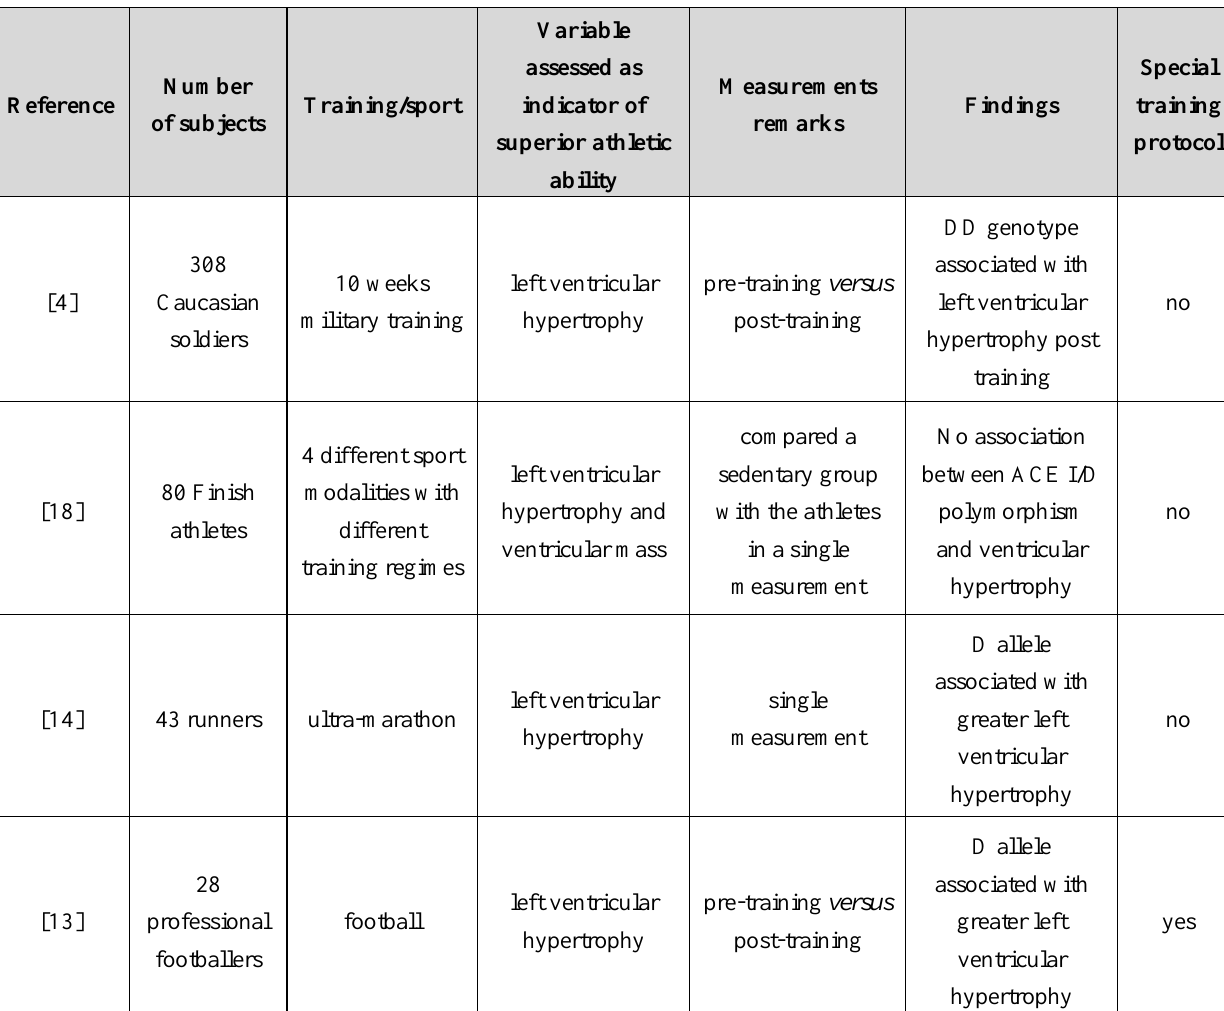
Table 1. Summary of publications addressing the association between the I/D ACE polymorphism and ventricular hypertrophy as an indication of improved athletic ability and/or training in a variety of athletic modalities, athlete quality and ethnicities. Table adapted from previous work by the authors